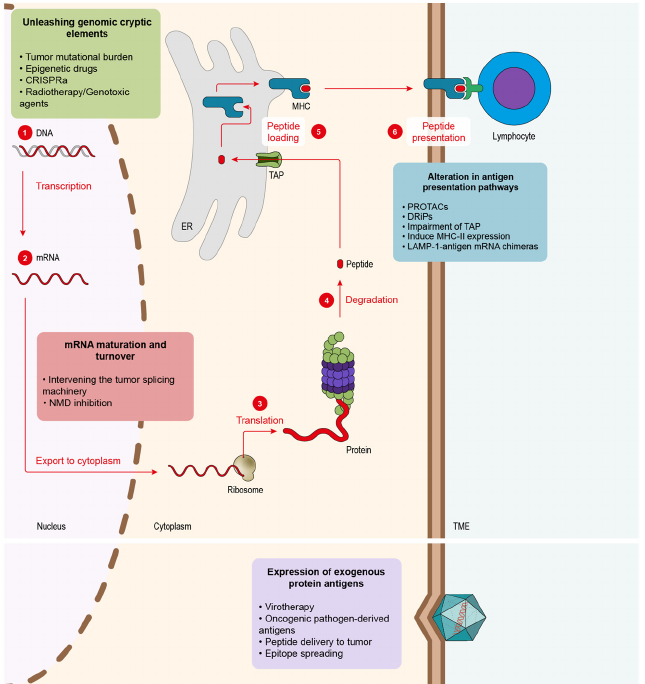
Figure 1. Tumor antigenicity can be enhanced at different levels. Endogenous tumor antigens can be fostered by altering different pathways in the tumor cells: 1. Genomic DNA contains an excellent source of dormant antigens that can be unleashed via several strategies: epigenetic drugs, radiotherapy, genotoxic drugs or CRISPRa. 2. Modulation of mRNAs maturation and homeostasis can lead to novel tumor antigens. Aberrant mRNAs might be generated via splicing inhibition or NMD blockade. 3–6. Proteins must be degraded to obtain antigenic peptides that are refined in the ER until the final ones are presented via MHC. Several strategies can be used to boost peptide-derived neoantigens at the protein level: PROTACs that induce selective target protein degradation, approaches that favor DRiP generation, TAP inhibition, induction of MHC-II presentation in tumor cells. Another source of antigens can be supplied by exogenous proteins.